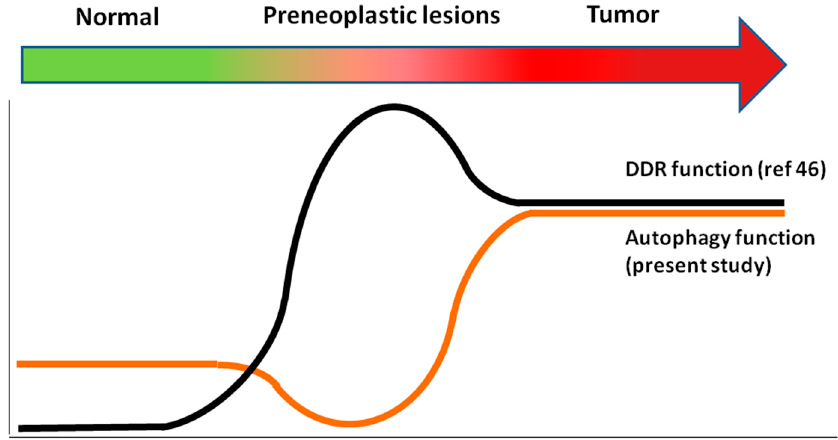
Figure 8. Schematic representation of the interrelationship of DDR pathway and autophagy during carcinogenesis (for details see results-discussion and conclusion).